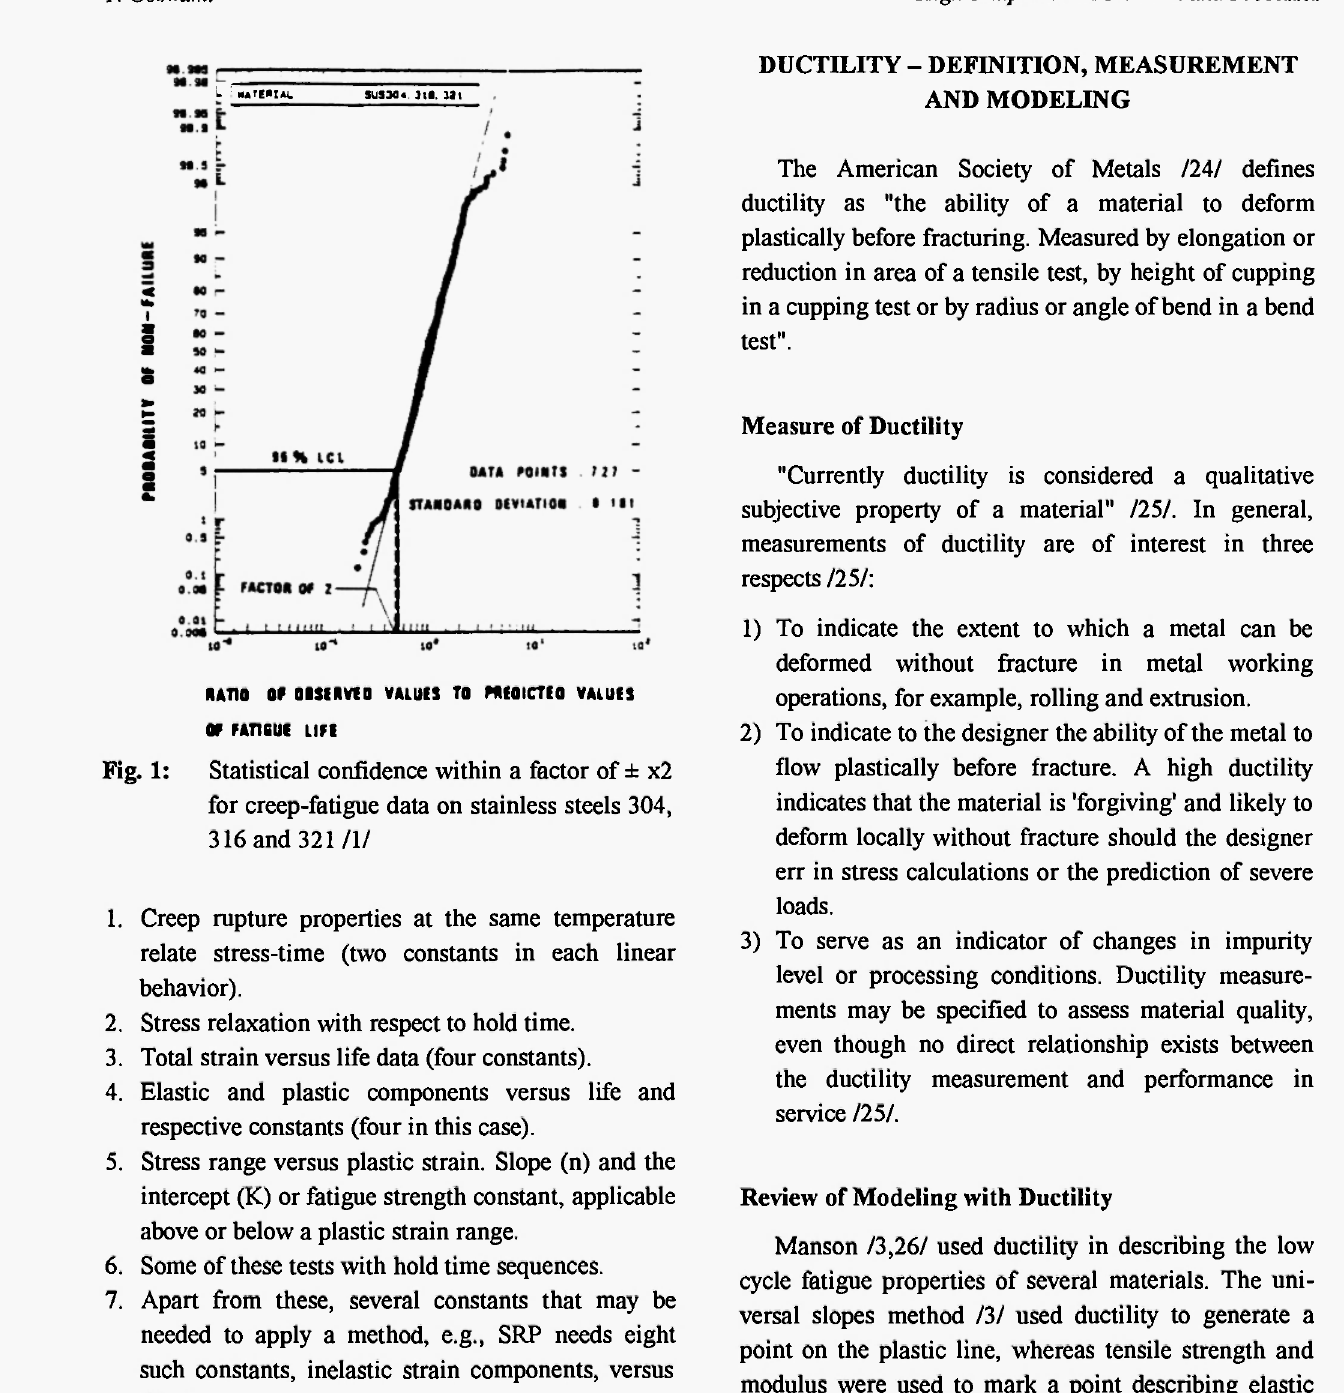
RATIO or 0 I « » «0 VALUES TO PKIOICTEO VAIUIS or FATisui un Fig. 1: Statistical confidence within a factor of ± x2 for creep-fatigue data on stainless steels 304, 316 and 321